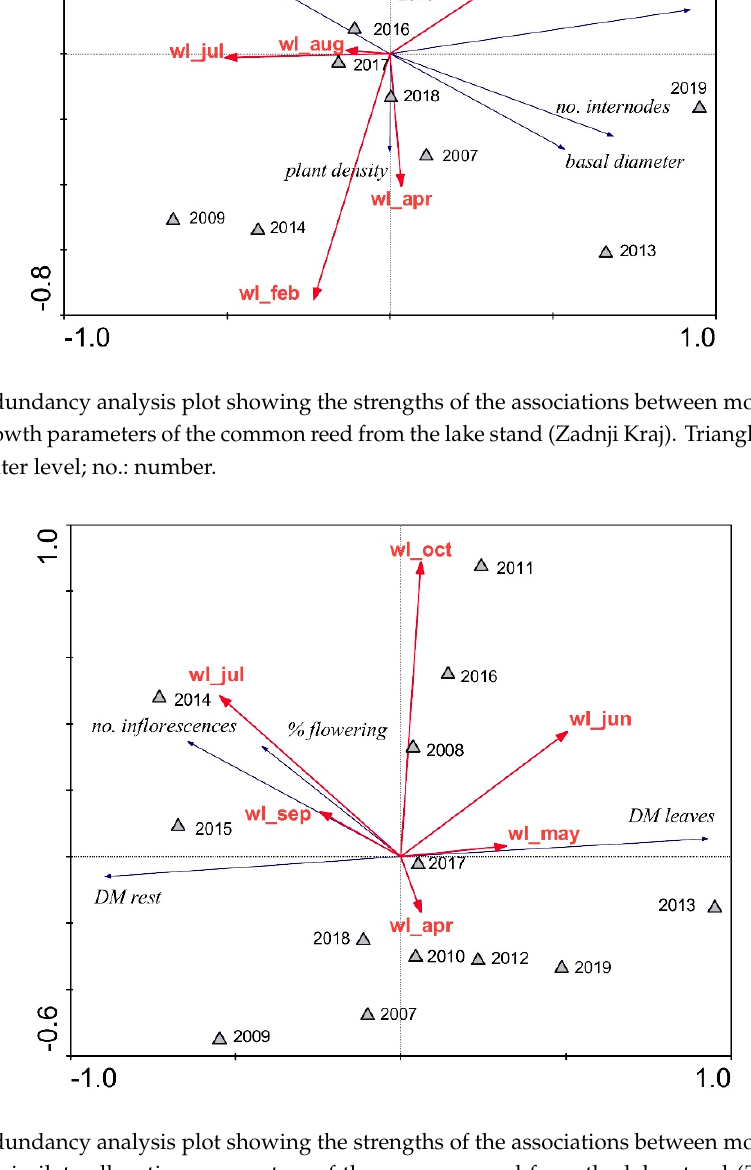
levels and assimilate allocation parameters of the common reed from the lake stand (Zadnji Kraj).